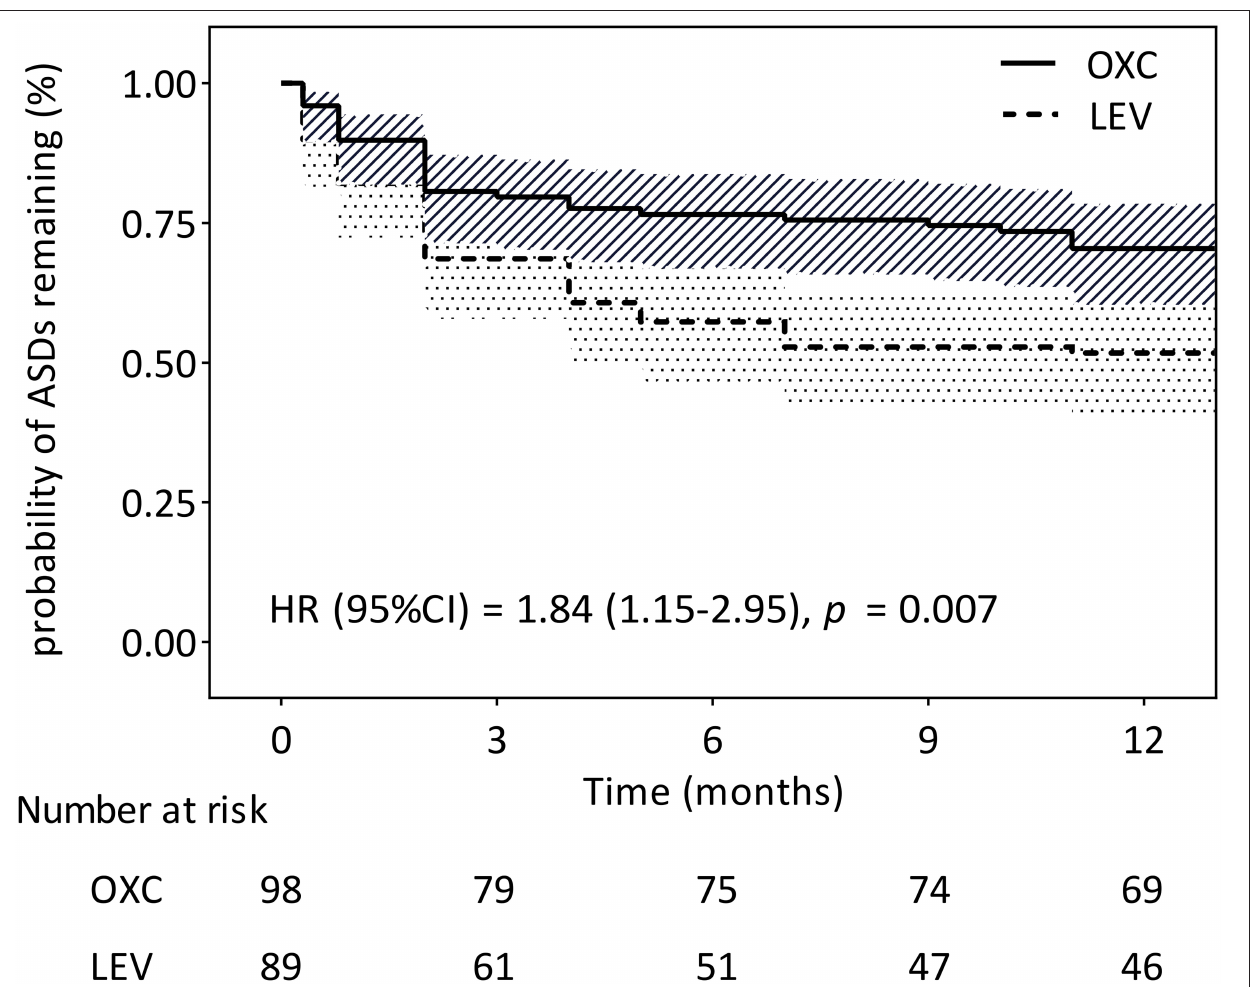
FIGURE 3 | Kaplan–Meier survival analysis of discontinuation between the two treatment groups ( n = 187). CI, confidence interval; HR, hazard ratio.